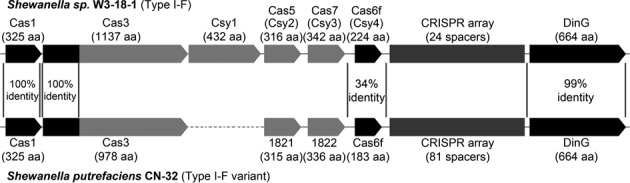
Comparison of CRISPR-Cas systems in S. putrefaciens strains. Schematic diagrams show the single CRISPR-Cas systems from S. putrefaciens W3–18–1 (Sputw3181_2191- Sputw3181_2185, Type I-F) and S. putrefaciens CN-32 (Sputcn32_1819 – Sputcn32_1824, Type I-F variant). The N-terminal 94 amino acids of the Cas3 proteins share 100% aa identity. The C-terminal Cas3 portion and the Cascade components do not reveal significant protein similarity.